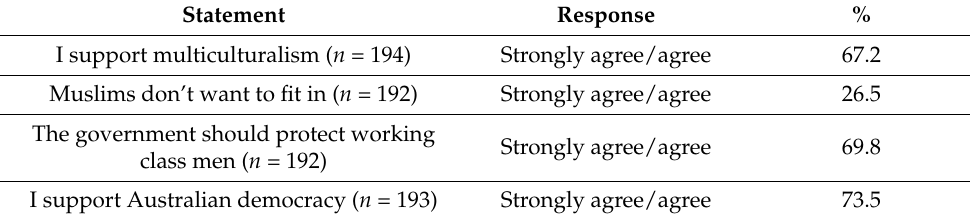
Table 7. Younger men’s agreement with statements; 1 = strongly agree, 5 = strongly disagree. Statement